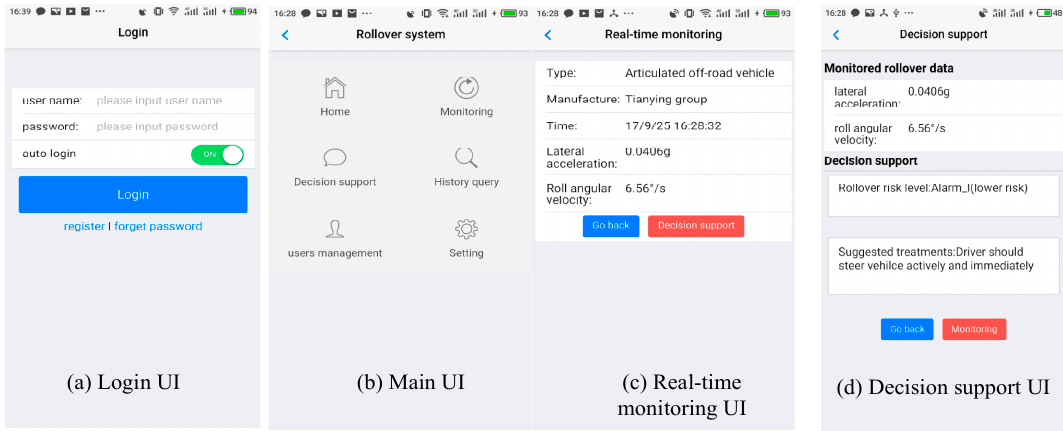
Figure 8. Analysis results of sample D in the PC application (APP).